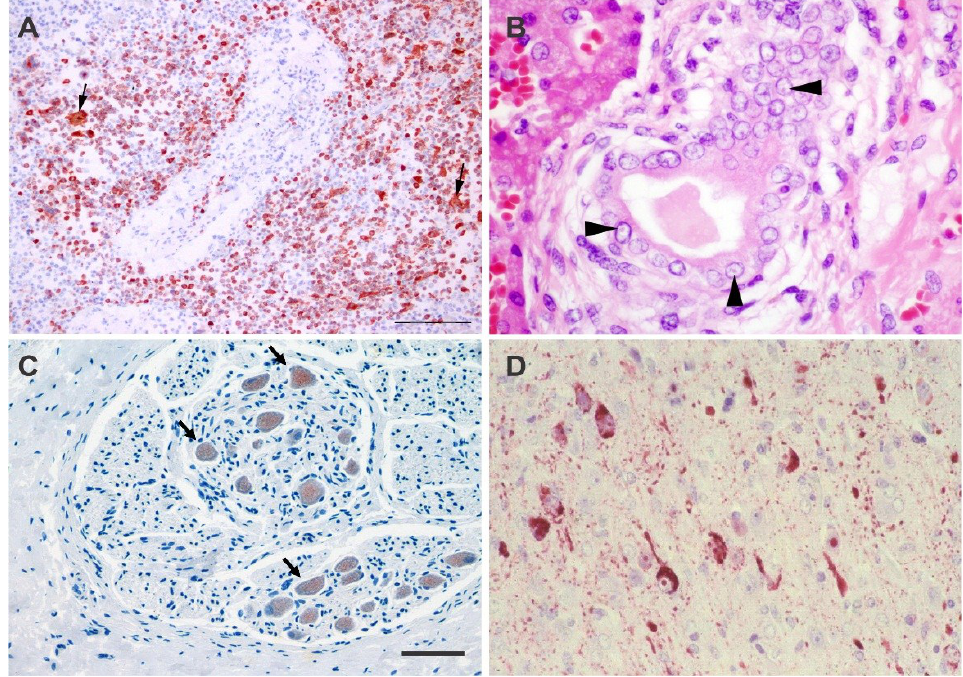
Figure 3. ( a ) Bottlenose dolphin ( Tursiops truncatus ), pulmonary lymph node, DMV infection, Canary Islands, Spain, 2005 (© IUSA, ULPGC). Positive intranuclear and intracytoplasmic immunoperoxidase staining of morbilliviral antigen in mononuclear and